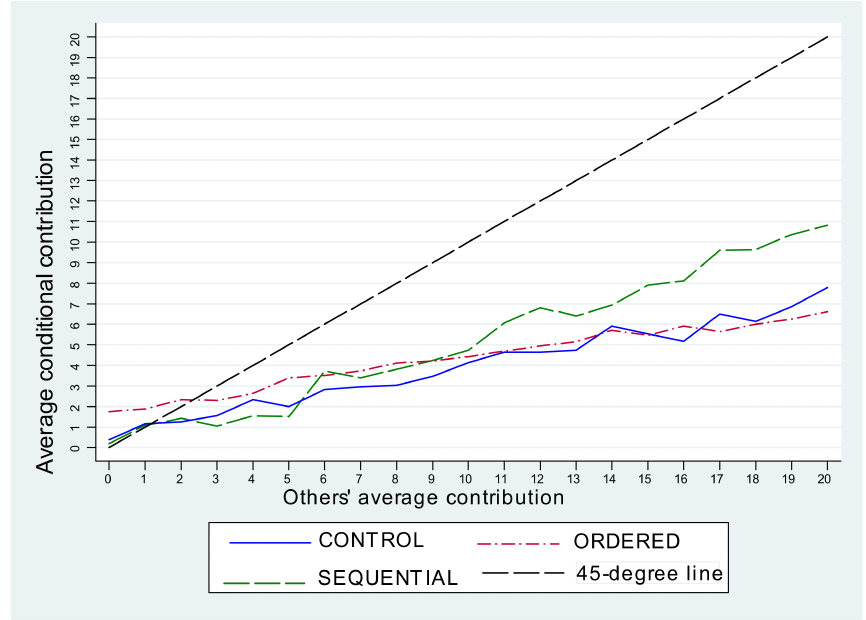
Figure A2. Average conditional contribution by treatment.